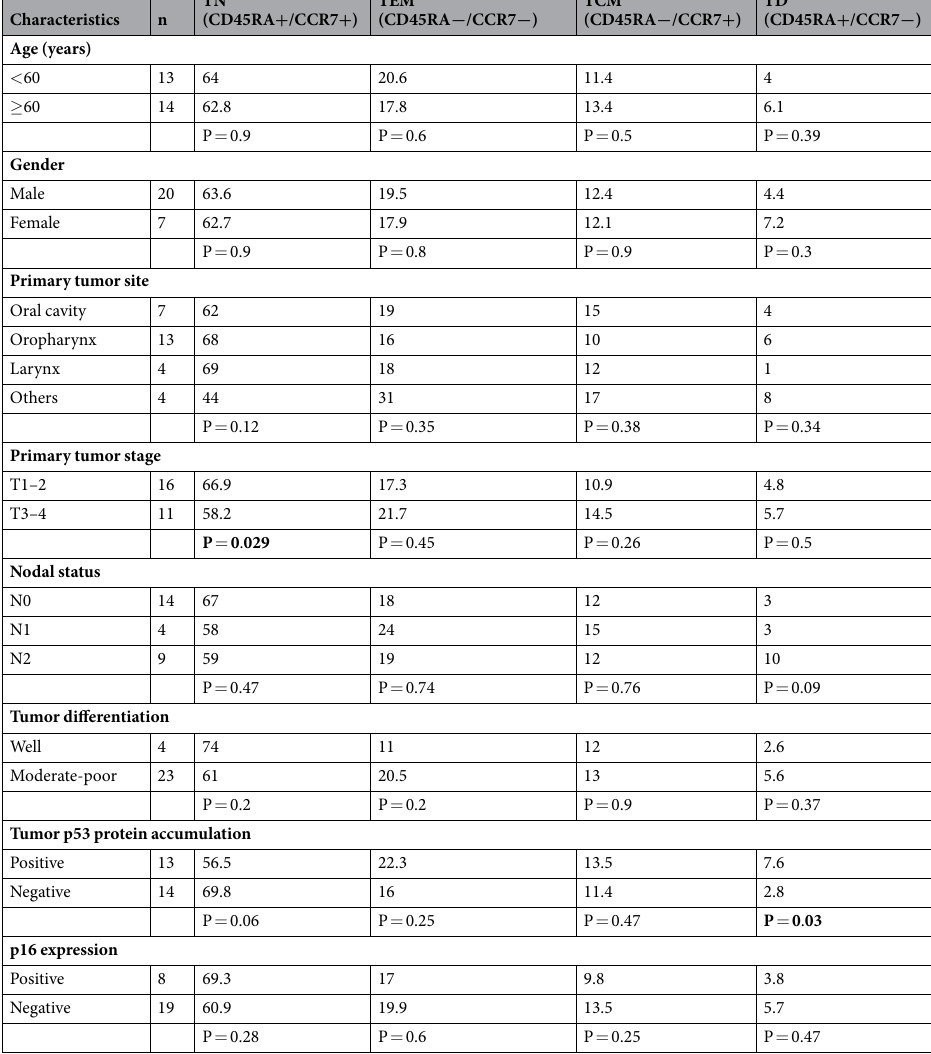
Table 4. Associations of clinicopathologic characteristics and phenotypes of circulating wt p53-specific tet 264–272 + CD8 + T cells in 27 patients with